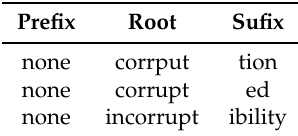
Table 2. Stemmed lexical variations.